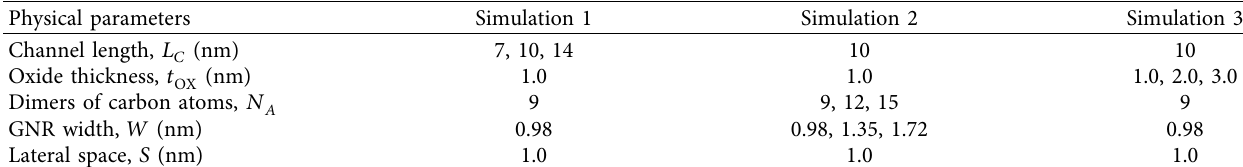
Table 1: Physical device structure of DG-SB-GNRFETs.